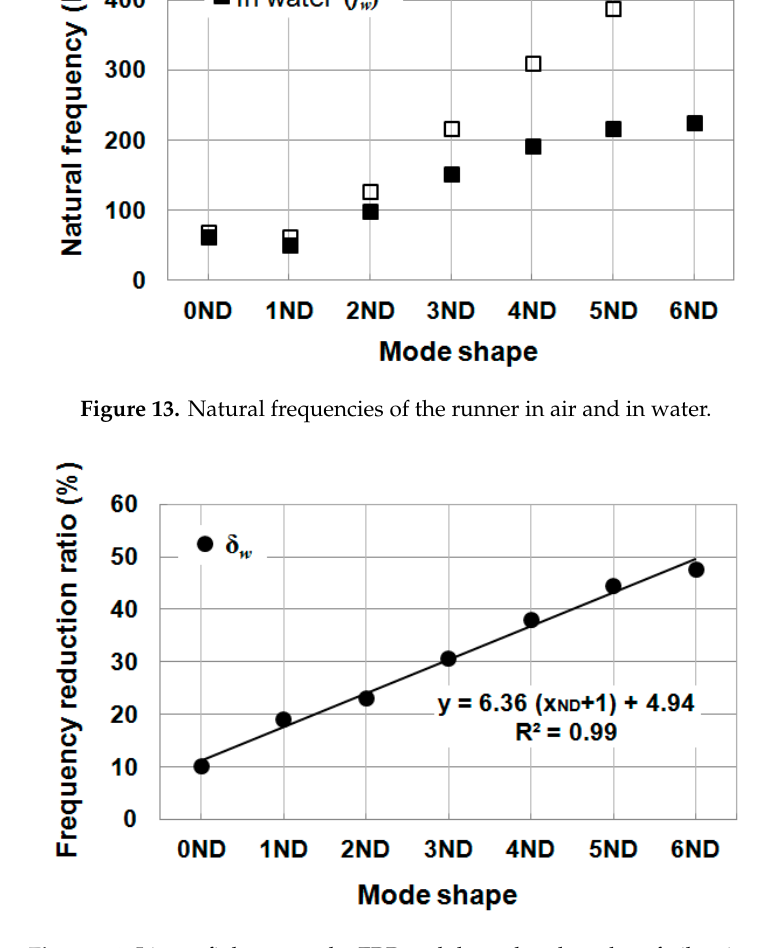
Figure 14. Linear fit between the FRR and the ordered modes of vibration.